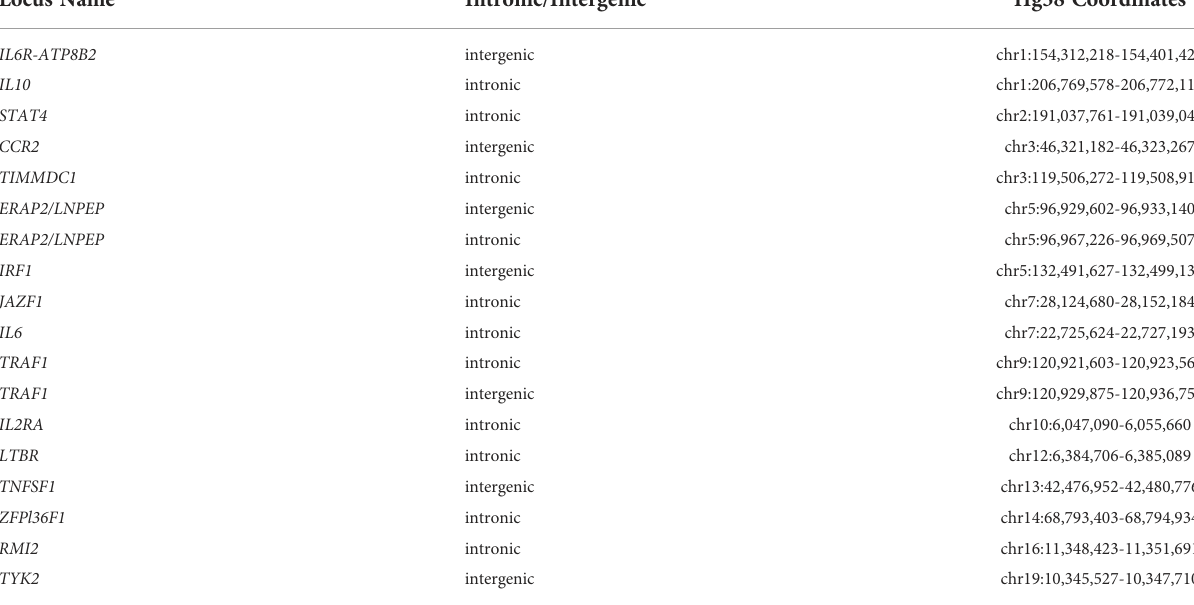
TABLE 3 Chromatin coordinates of enhancers identi fi ed by MPRA in unstimulated K562 in